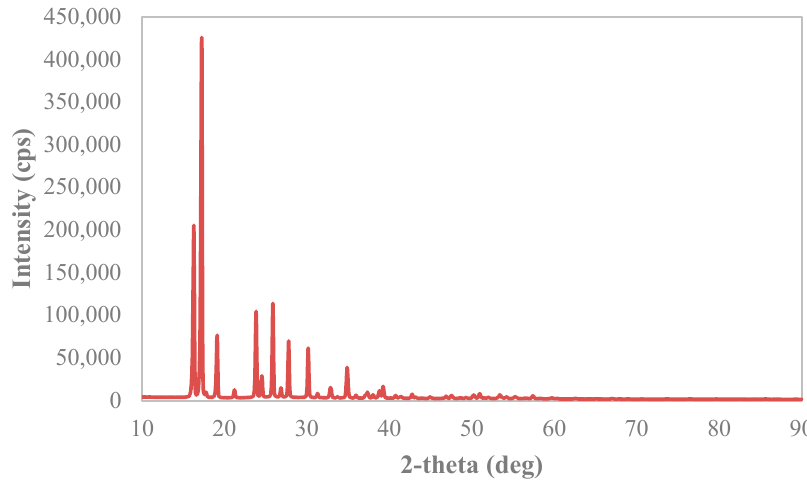
Figure A5. X-ray diffraction spectra of benzoic acid as original sample.